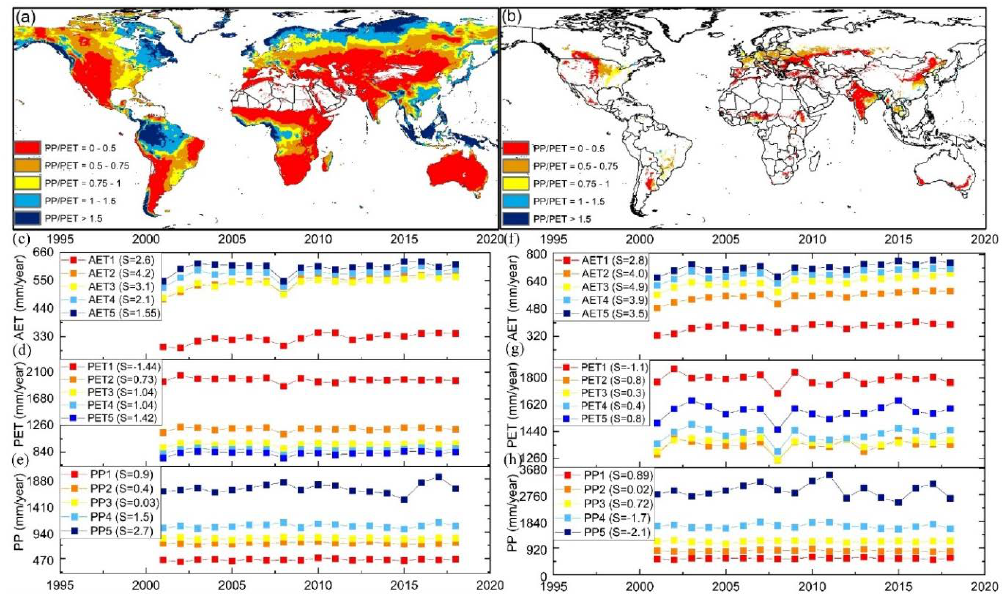
Figure 7. ( a ) Global energy-limited and water-limited areas in five classes. ( b ) Energy-limited and water-limited croplands in five classes: ( c ) global annual AET, ( d ) global annual PET, ( e ) global annual PP, ( f ) croplands’ annual AET, ( g ) croplands’ annual PET, ( h ) croplands’ annual PP.